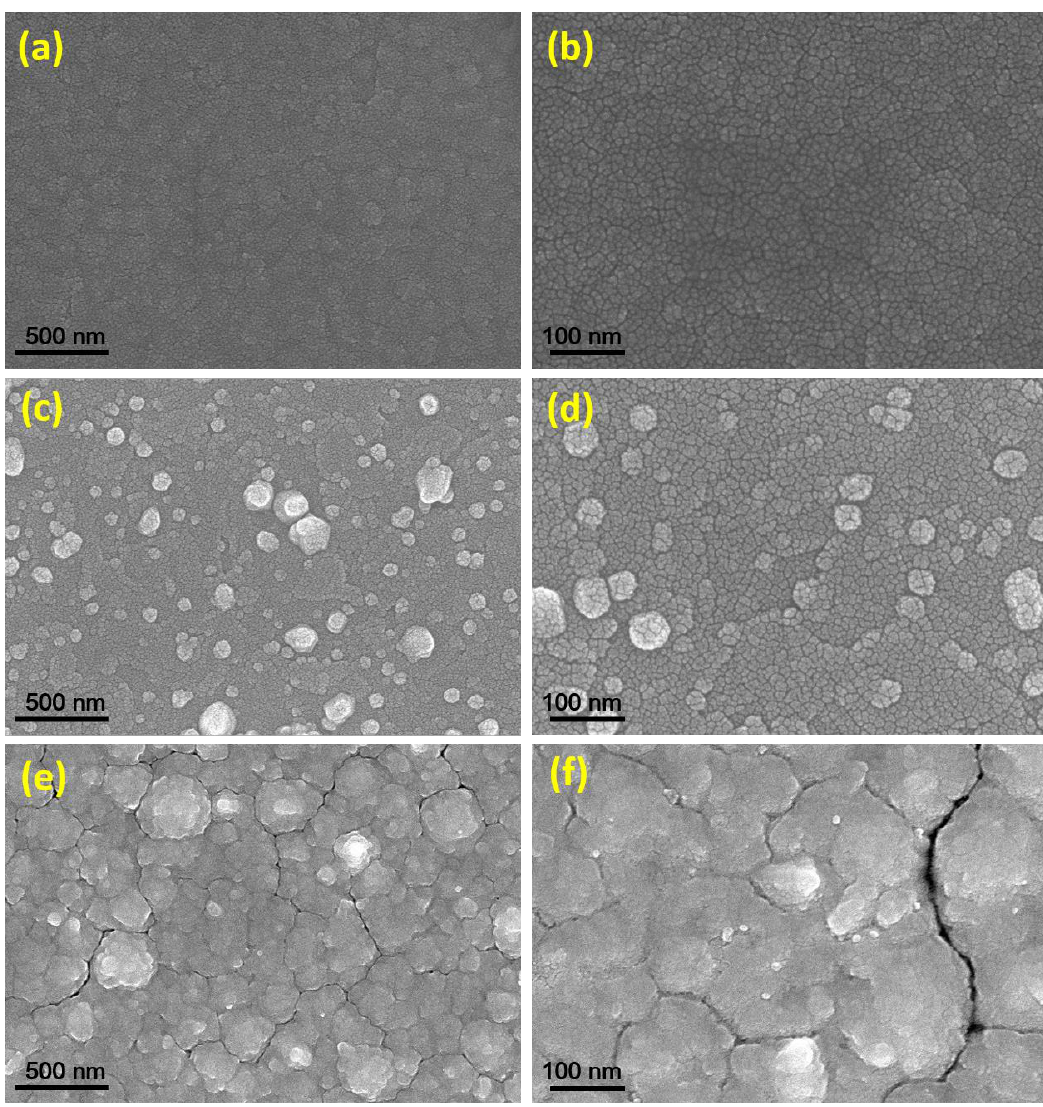
Figure 3. SEM images of the evaporated Ag 2 Se samples. ( a,b ) Ag 2 Se-100, ( c,d ) Ag 2 Se-150 and ( e,f ) Ag 2 Se-200.